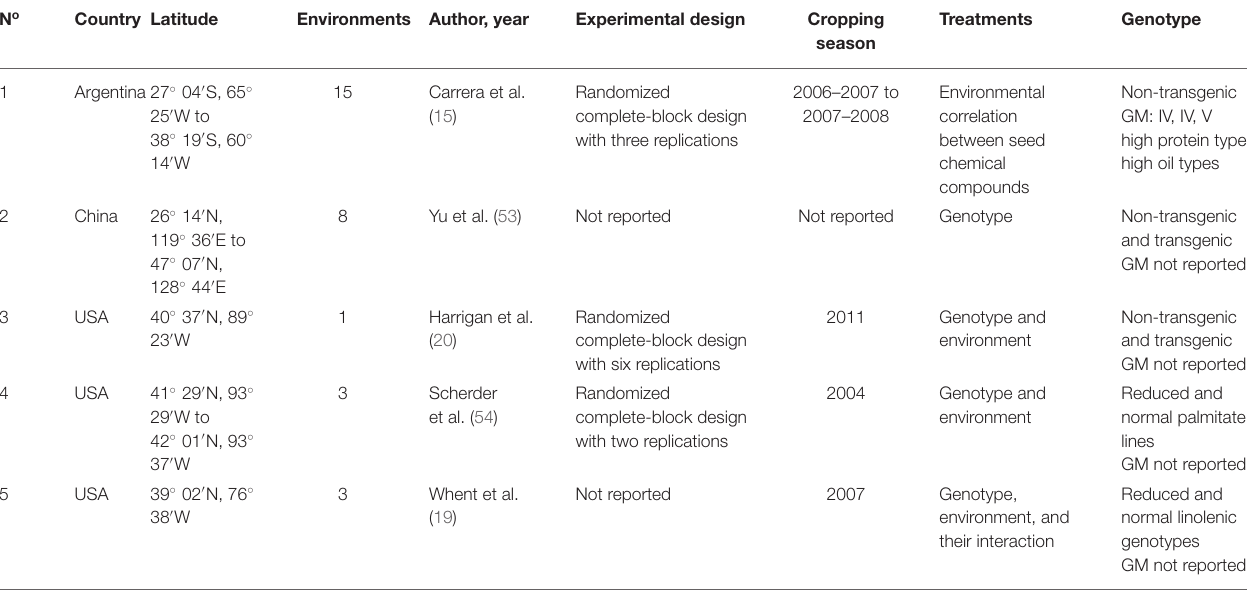
TABLE 2 | Number of study, country, latitude, number of involved environments defined as crop year, location, and sowing date combinations, author and year of publication, experimental conditions and design, cropping season, treatments evaluated, and genotype type for each study included in the soybean seed oil and tocopherol meta-data base.